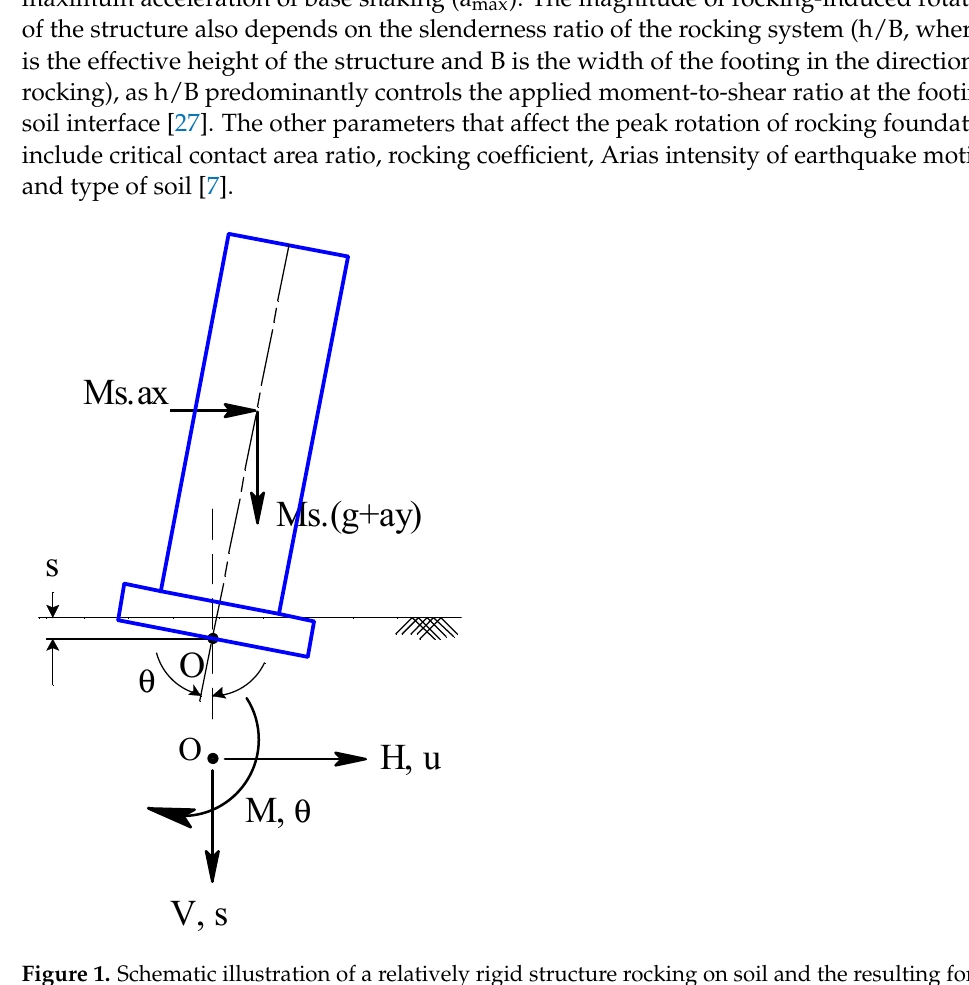
Figure 1. Schematic illustration of a relatively rigid structure rocking on soil and the resulting forces and displacements at soil–foundation interface.